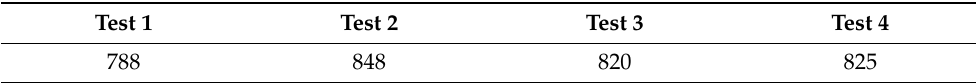
Table 4. Example 2: Results from four tests for the graph model.